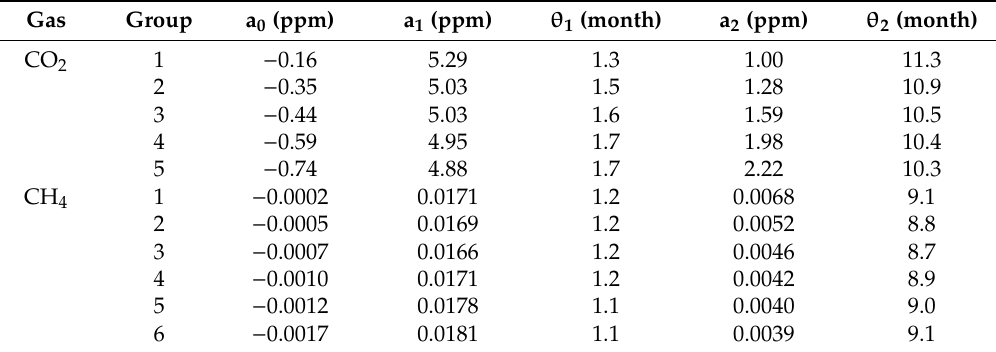
Table 3. Parameters of Equation